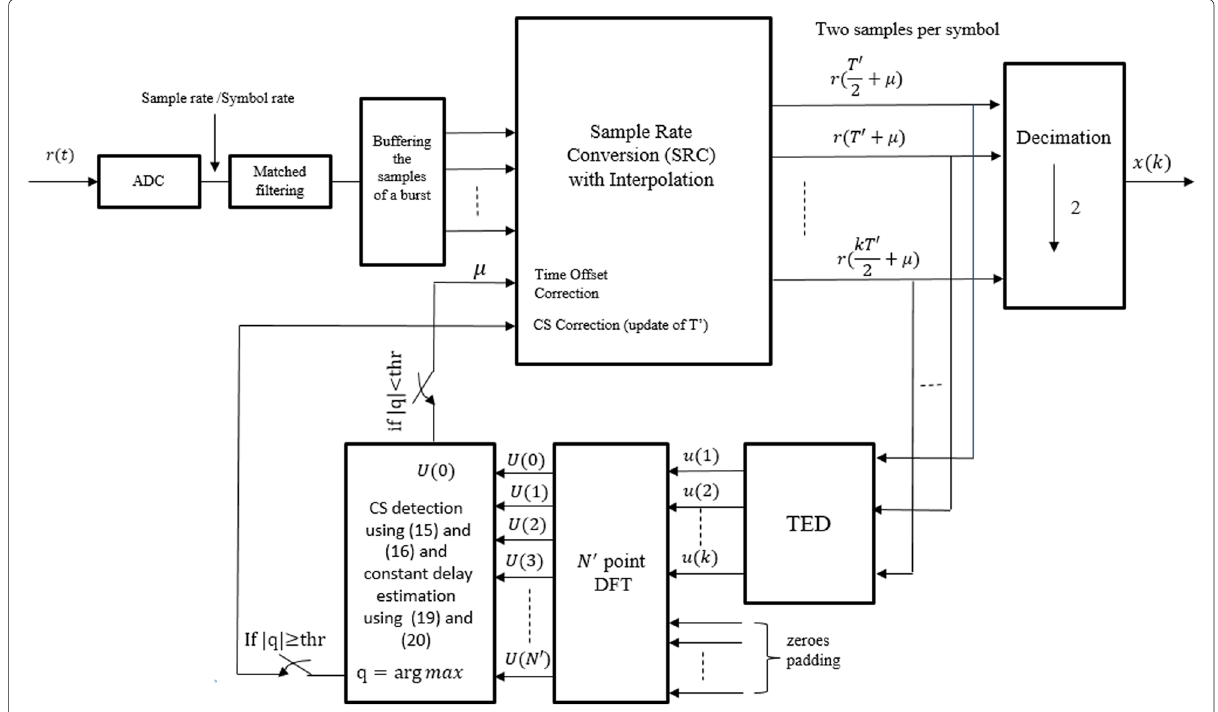
Fig. 5 Block diagram of CS correction proposed timing recovery algorithm for burst